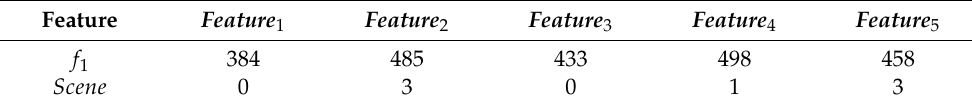
Table 2. Examples features of calculating AMI.